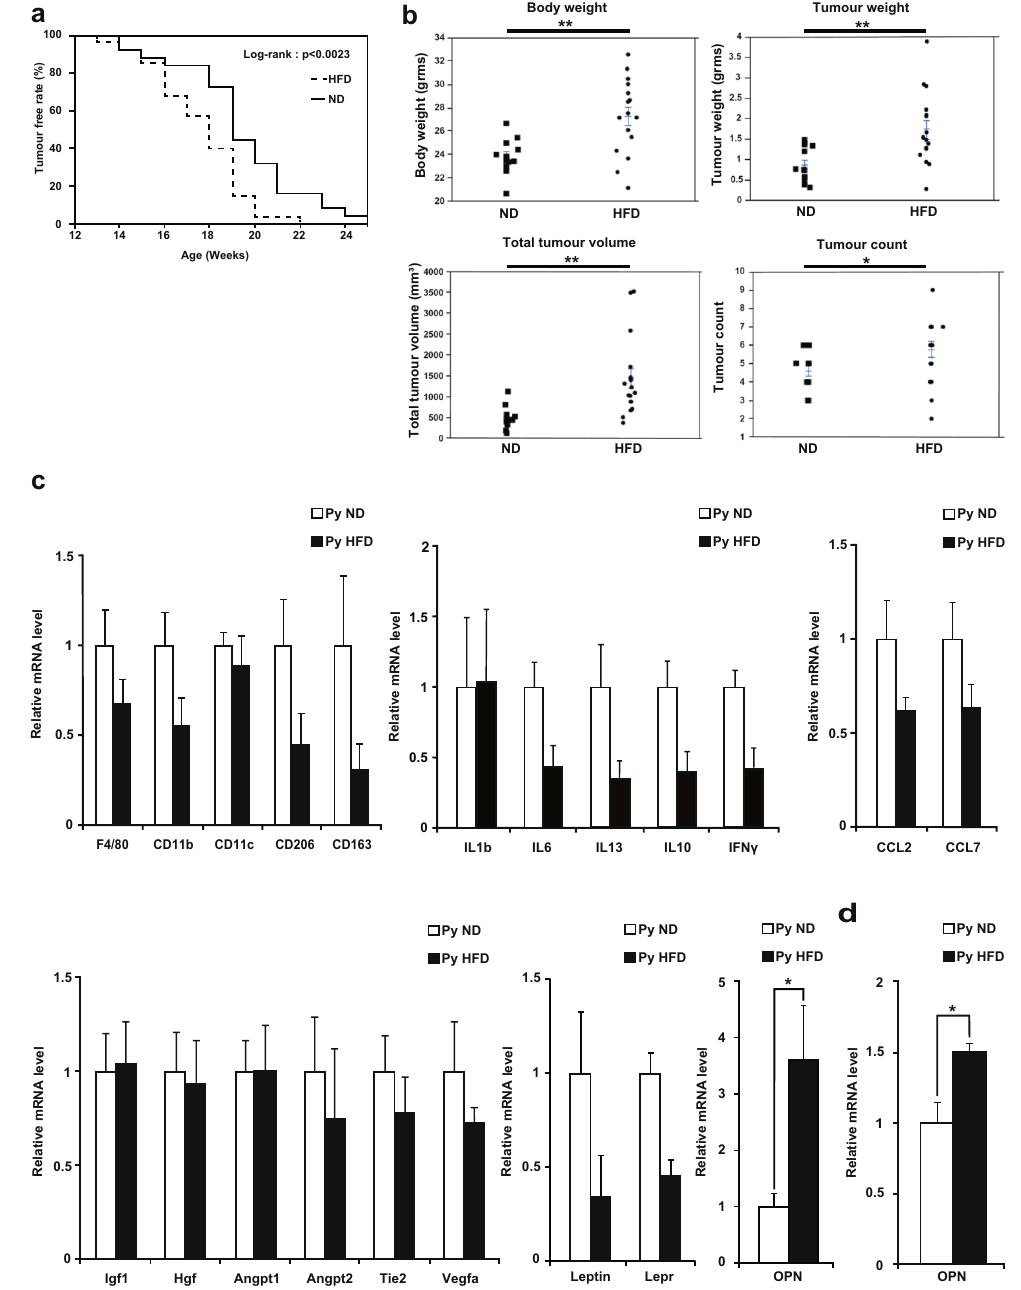
Figure 1. High-fat diet promotes tumour initiation and progression. ( a ) Survival curves of tumour-free ND- fed PyMT mice (n = 25) and HFD-fed PyMT mice (n = 28). ( b ) Body weights, tumour weights, total tumour volumes, and tumour counts of ND-fed PyMT mice (n = 13) and HFD-fed PyMT mice (n = 16) at 20 weeks of age. ( c ) Quantitative RT-PCR analysis of the mRNA levels of macrophage markers, proinflammatory cytokines, angiogenic markers, myeloid chemoattractants, Opn , Leptin , and Lepr in tumours harvested from ND-fed PyMT mice and HFD-fed PyMT mice at 20 weeks of age (n = 4 per group). ( d ) Quantitative RT-PCR analysis of Opn mRNA expression in fractions of tumours from ND-fed PyMT mice and HFD-fed PyMT mice after depleting adipocytes by centrifugation (n = 3 per group). Error bars indicate the s.e.m. * P < 0.05 and ** P <